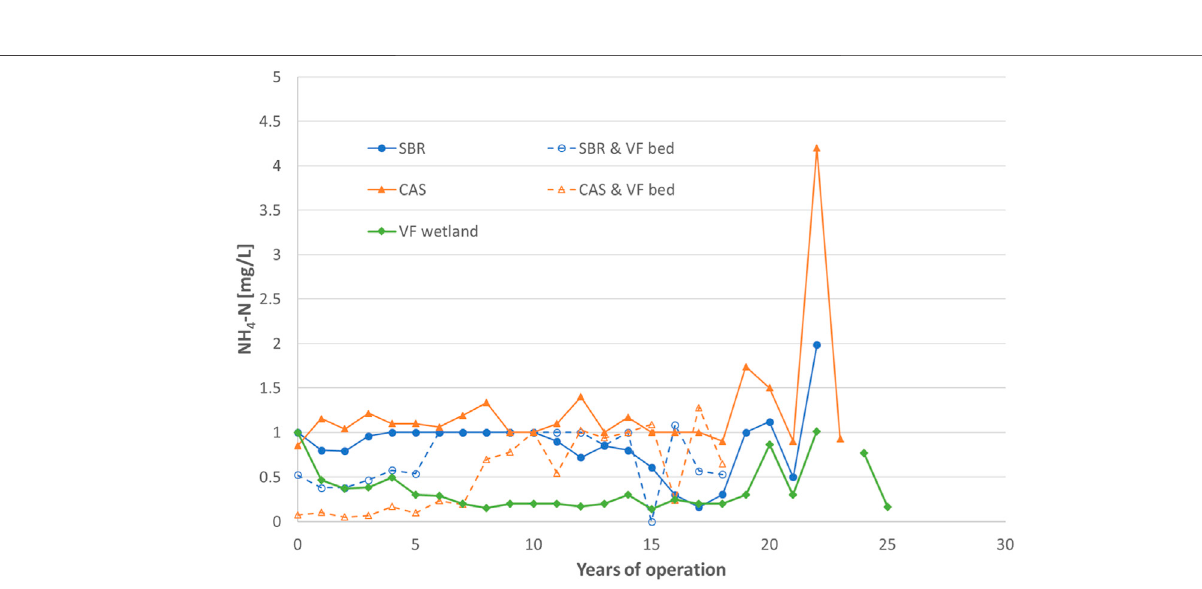
Frontiers in Environmental Science |